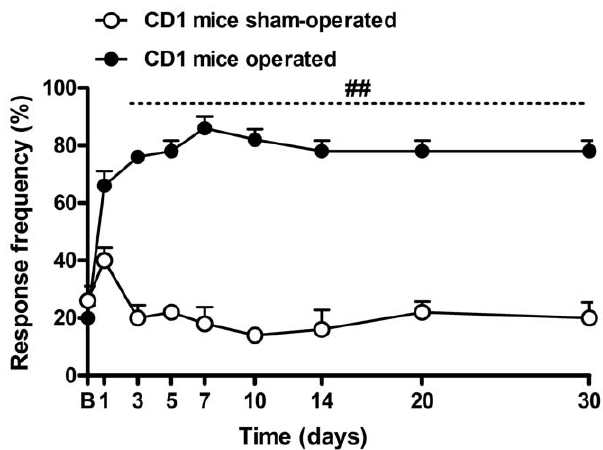
Figure 1. Mechanical allodynia induced by brachial plexus avulsion (BPA) in mice. Response of frequency of the right hindpaw assessed at several time-points by von Frey hair 0.4 g in sham-operated and operated (BPA) mice. Data are expressed as mean 6 SEM (n=4–6/ group). ## p , 0.01, significantly different from the sham-operated group (two-way ANOVA with Bonferroni’s post hoc test). B, Baseline withdrawal threshold before surgery.